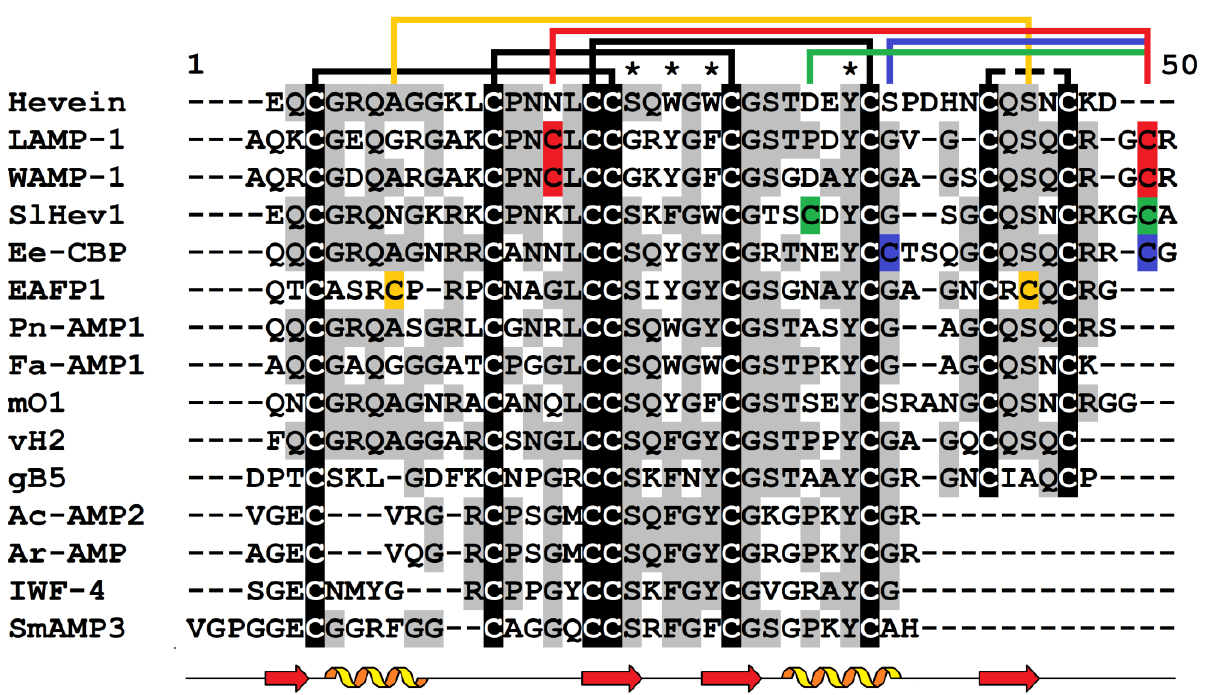
Figure 3. Multiple sequence alignment of hevein (UniProt P02877.2) and selected hevein-like AMPs: LAMP-1 (UniProt P86521.2) from Leymus arenarius and WAMP-1 (UniProt P85966.2) from Triticum kiharae ; SlHev1 (GenBank UXX20393.1) from Solanum lycopersicum ; Ee-CBP1 (GenBank AAP35269.1) from Euonymus europaeus ; EAFP1 from Eucommia ulmoides (UniProt P83596.1); Pn-AMP1